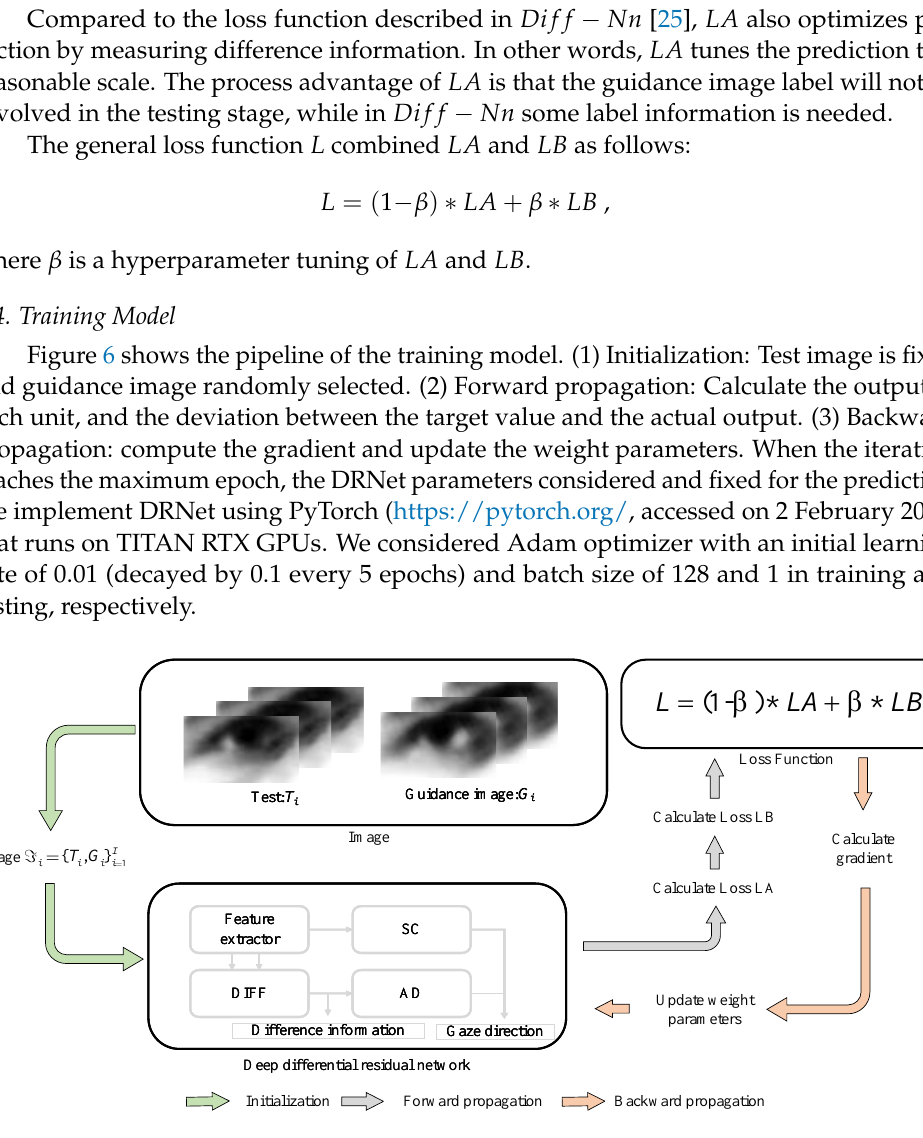
Figure 6. Flow chart of the training